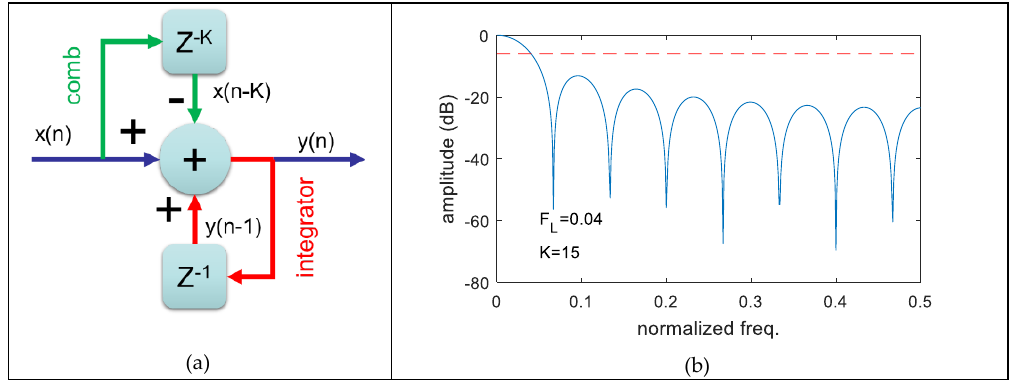
Figure 2. ( a ) Integrated-comb (IC) cell of cascaded-IC (CIC) filter and ( b ) an example of frequency mask obtained for K = 15, which corresponds to normalized cut-off frequency F L = 0.04. Horizontal dashed line represents the −6 dB level.